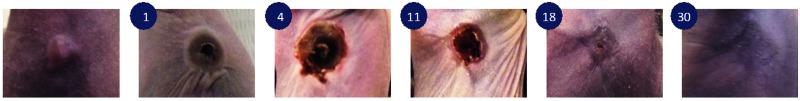
Thermal reaction, gradual healing and complete ablation of tumour xenograft seen in vivo in a mouse that received IT GNRs and CW NIR laser irradiation for three minutes.The numbering indicates the days post-irradiation while the first (un-numbered) image is the pre-irradiated tumour. The irradiated site was excised at day 30 and TEM analysis is shown in Fig 10(d)–10(h).